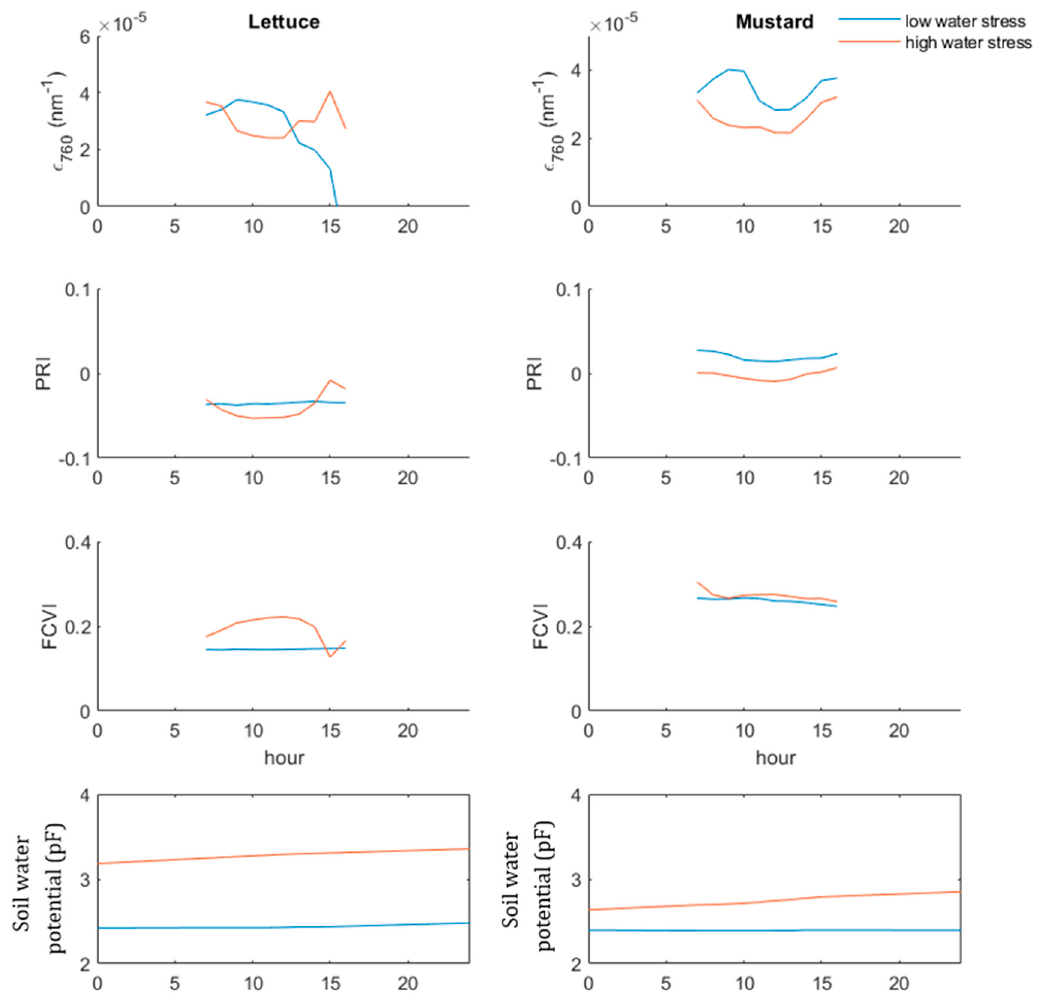
Figure 4. Behavior of ϵ 760 , PRI and FCVI for three days during the lettuce experiment. For the lettuce dataset, DOY 244 was the unstressed day (blue line), DOY 247 the stressed one (red line). For the mustard dataset, DOY 198 was the unstressed day (blue line), DOY 202 the stressed one (red line). The water stress conditions are indicated with the soil water potential.